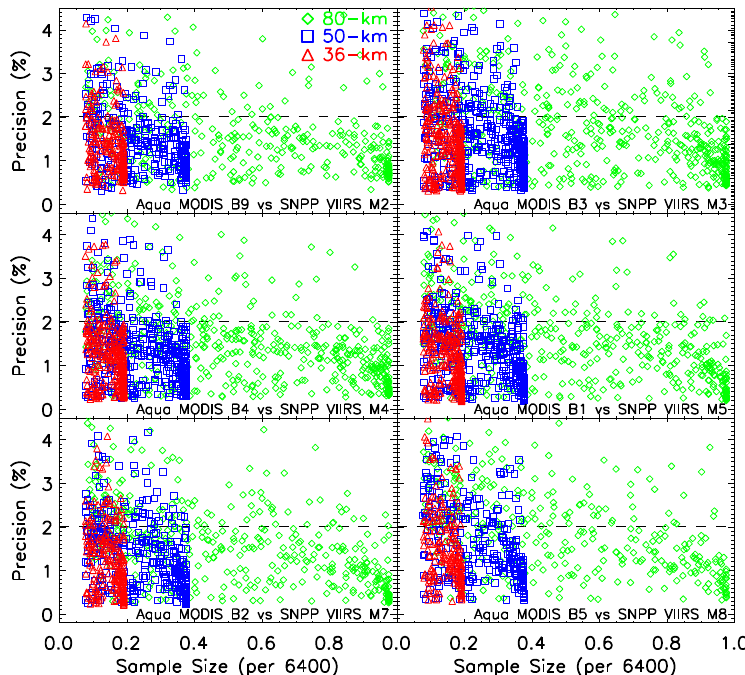
Figure 15. Precision versus sample size for six inter-RSB comparisons of Aqua MODIS versus SNPP